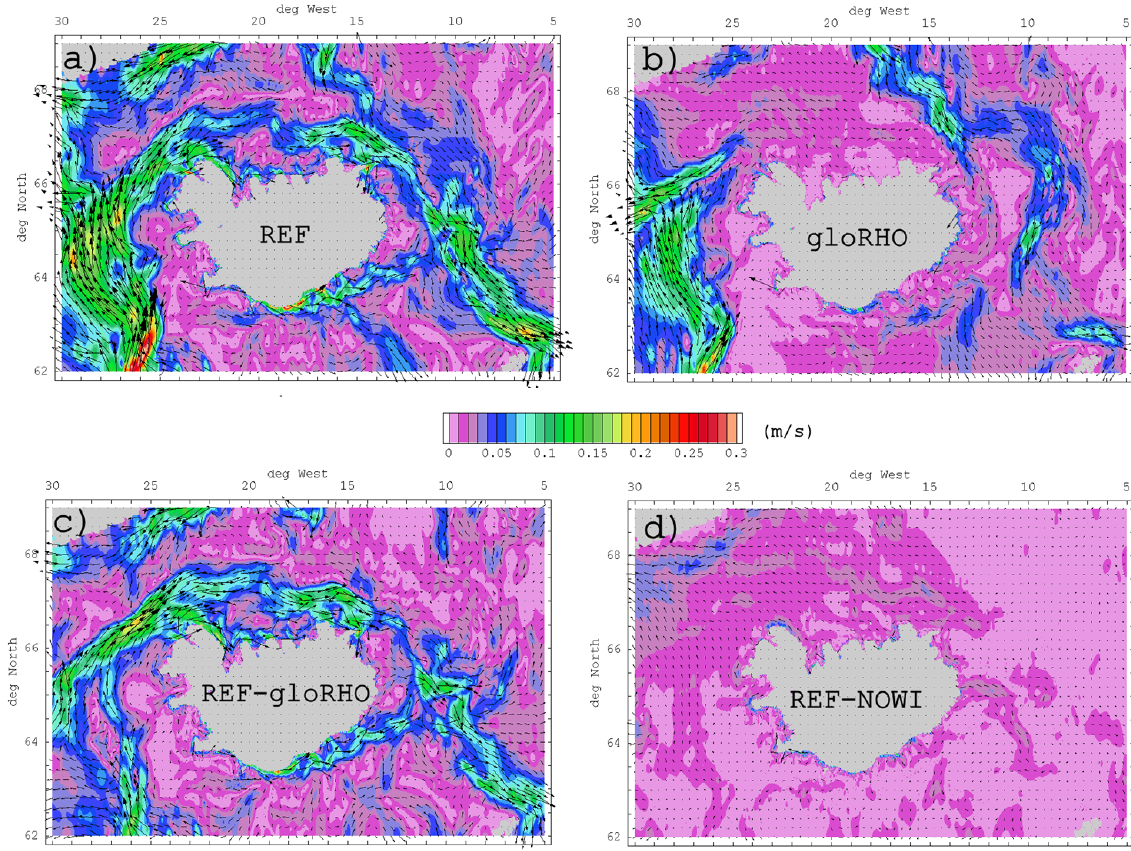
Fig. 15. Results of the sensitivity experiments gloRHO and NOWI. August 2003 to December 2003 mean flow fields at the depth of 15m simulated by (a) the reference run and (b) the experiment gloRHO. (c) Shows the difference of both fields (gloRHO subtracted from the reference run). (d) Shows the results of experiment NOWI subtracted from the reference